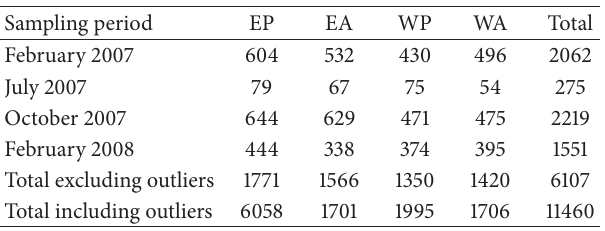
Table 4: Pitfall abundances and totals a for each sampling area and period.